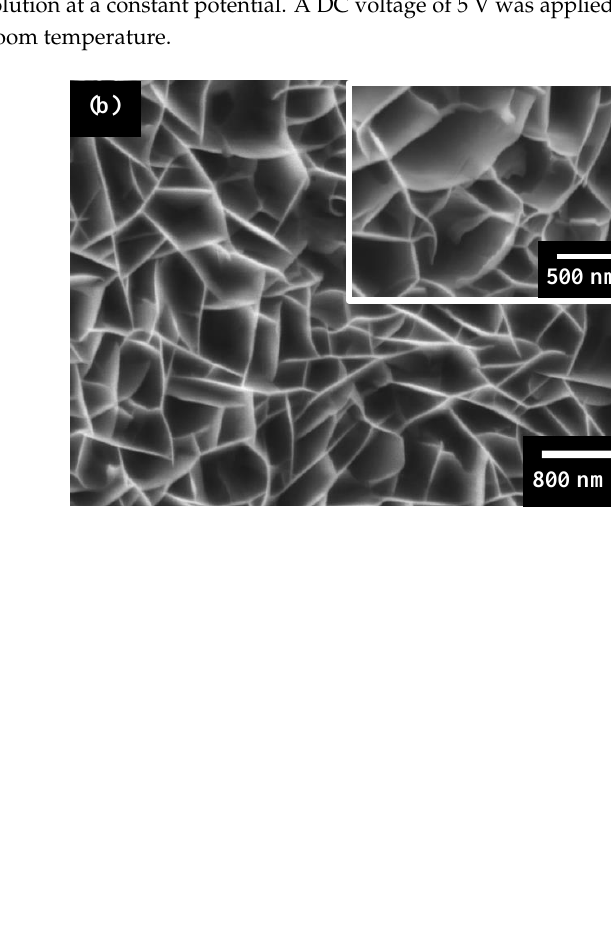
Figure 2. SEM surface morphologies: ( a ) Li-Al-CO 3 LDH thin film on Al substrate (A6061 lathe waste strip) and its high-magnification image in ( b ); ( c ) Li-Al-CO 3 LDH thin film calcined at 400 °C for 1 h.